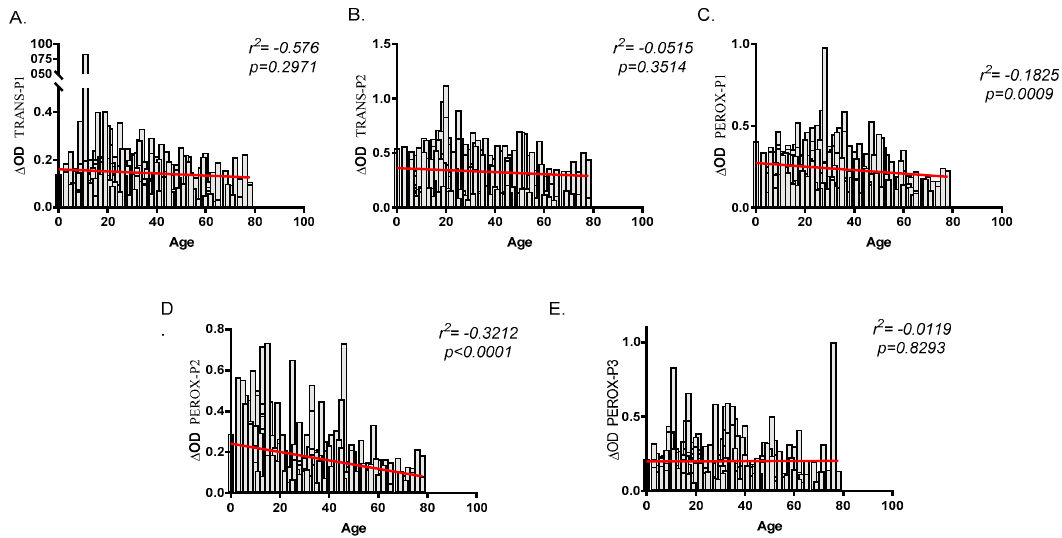
Figure 2. Correlation analysis between age and IgG antibody levels against each one of the salivary peptides ( A – E ). Spearman rank correlation was used to test significance with a p < 0.05.